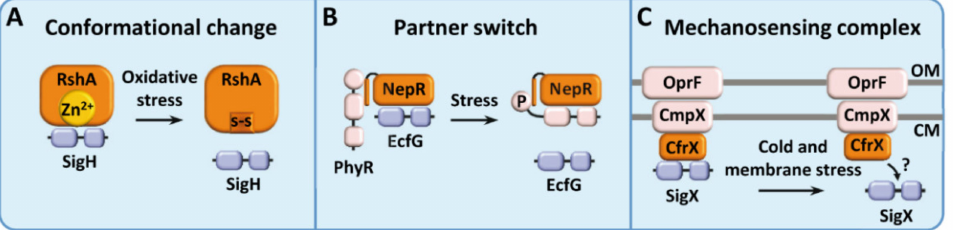
Figure 1. Regulation of non-canonical ECF sigma factors associated to soluble anti-sigma factors, exemplified by known ECFs and activating stresses. ECF sigma factors are depicted in blue, whereas proteins acting as anti-sigma factors and other regulatory proteins are depicted in orange and pink, respectively. ( A ) Regulation by conformational change: RshA and SigH from M. tuberculosis ; ( B ) Part- ner switch in NepR-PhyR and EcfG complex from R. sphaeroides ; ( C ) Model for the mechanosensing complex governing the response of SigX in P. aeruginosa . OM: outer membrane; CM: cytoplas- mic